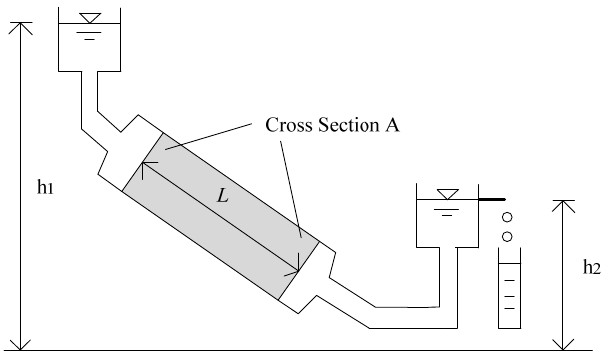
Figure 7. Illustration of Darcy’s law .